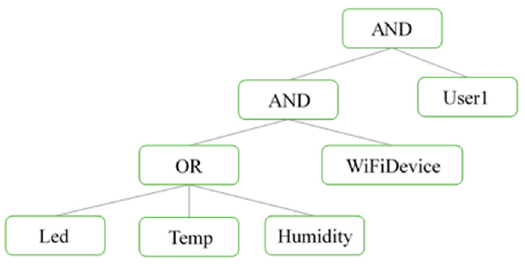
Figure 1. Access Figure 1. Access structure.